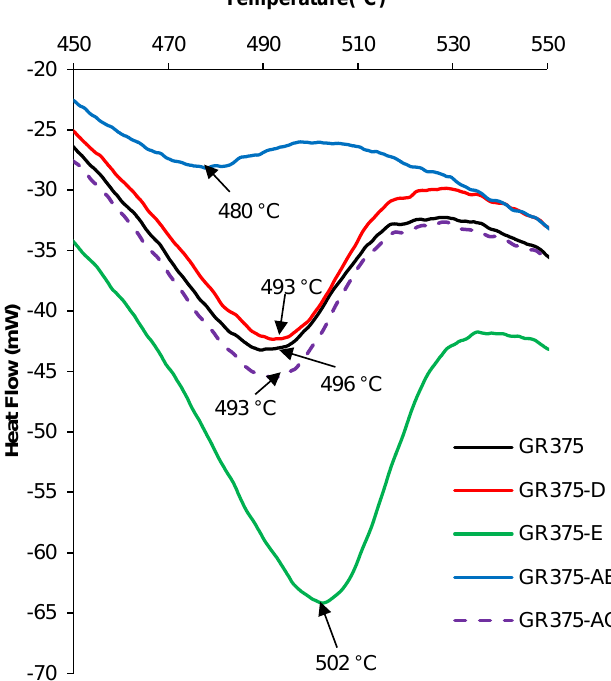
Figure 6. DSC dehydroxylation of the raw kaolinite (GR375); the kaolinite–DMSO (GR375-D) and the deintercalation products in water (GR375-E), in ethyl acetate (GR375-AE) and in acetone (GR375-AC). The registered dehydroxylation temperatures are 480, 493, and 502 ◦ C,